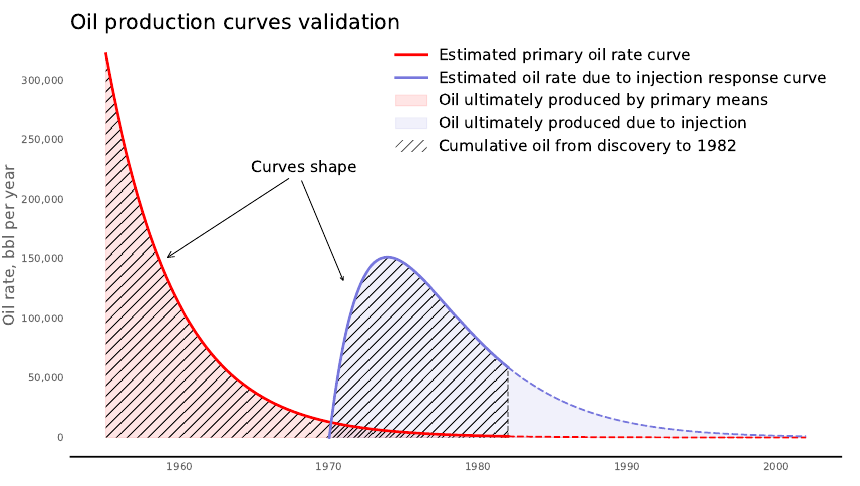
Figure 3. Plot visualizes parameters “primary ultimate oil”, “secondary ultimate oil”, “cumulative oil as of 1982” as different parts of the areas under the curves. To validate curve accuracies, we compared parameters calculated as areas under the curves with the same parameters stored in the